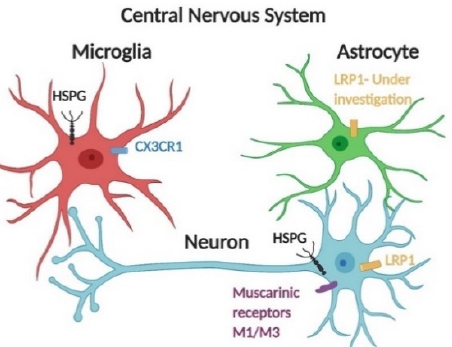
Figure 2. Receptor-mediated endocytosis of tau species is facilitated by several receptors. Central nervous system cells actively internalize monomeric tau via receptor-mediated endocytosis in addition to the HSPG-dependent pathway. Monomeric tau is internalized by muscarinic receptors M1 and M3 in neurons [43] . CX3CR1 mediates monomeric tau uptake in microglia [45] . For astrocytes, monomeric tau can be internalized in a non-HSPG dependent pathway [46] . Further work should be focused on identifying specific receptors of tau endocytosis. Additionally, LRP1 has recently been identified as a major regulator of tau spread in the brain [44] ; LRP1 is abundantly expressed by microglia, astrocytes, and neuronal cells [47,48] .